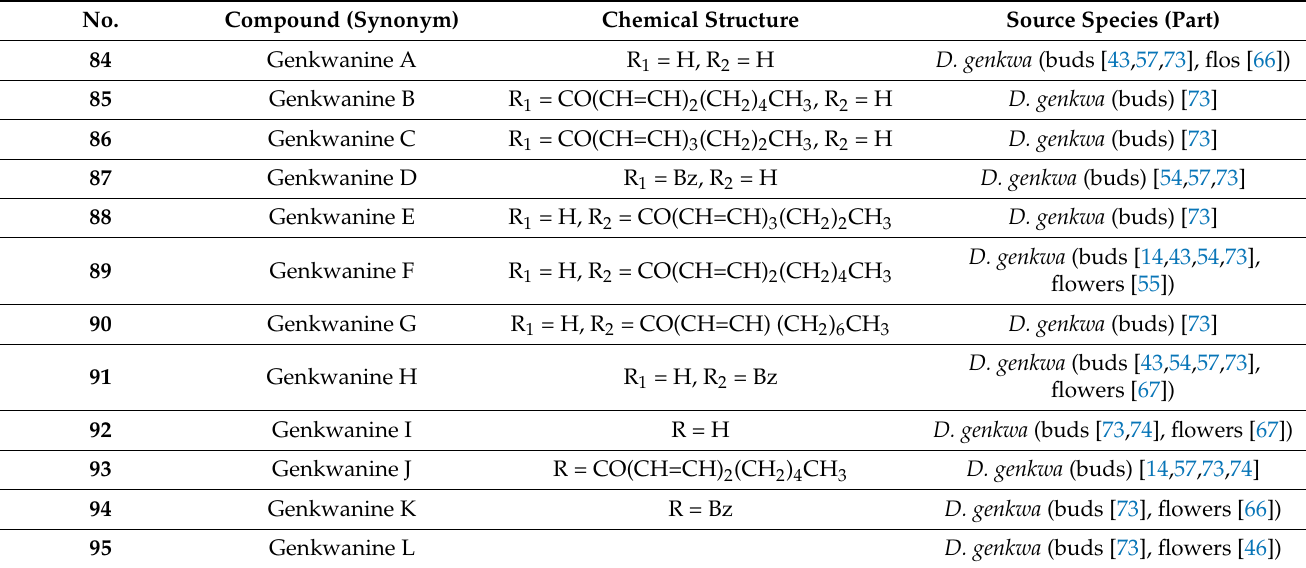
Table 3. Structures and sources of genkwanines ( 84 – 95